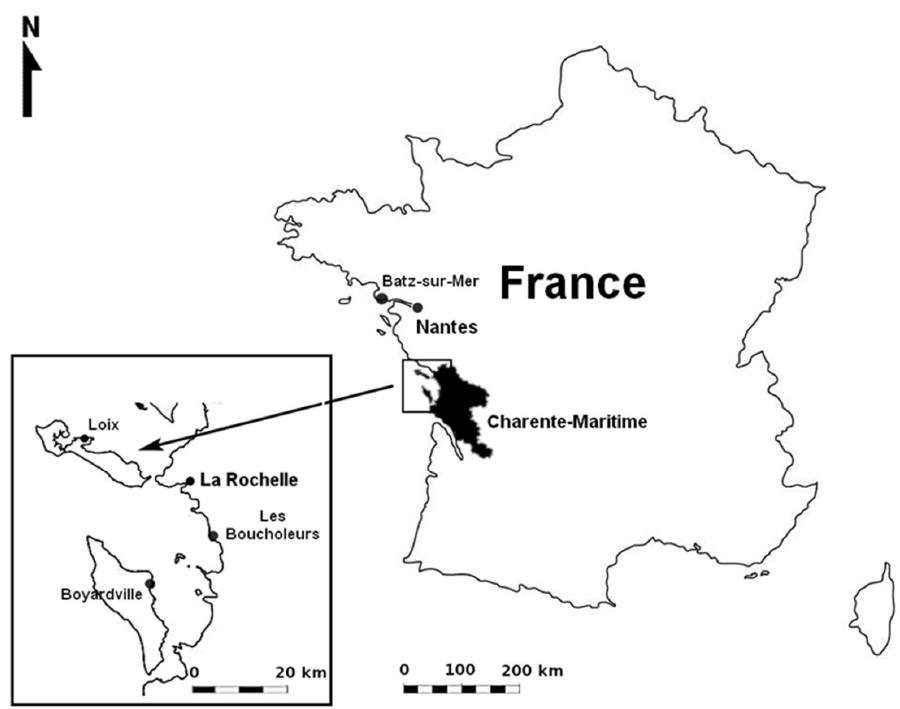
Figure 1. Locations of the four sites used to develop the methodology